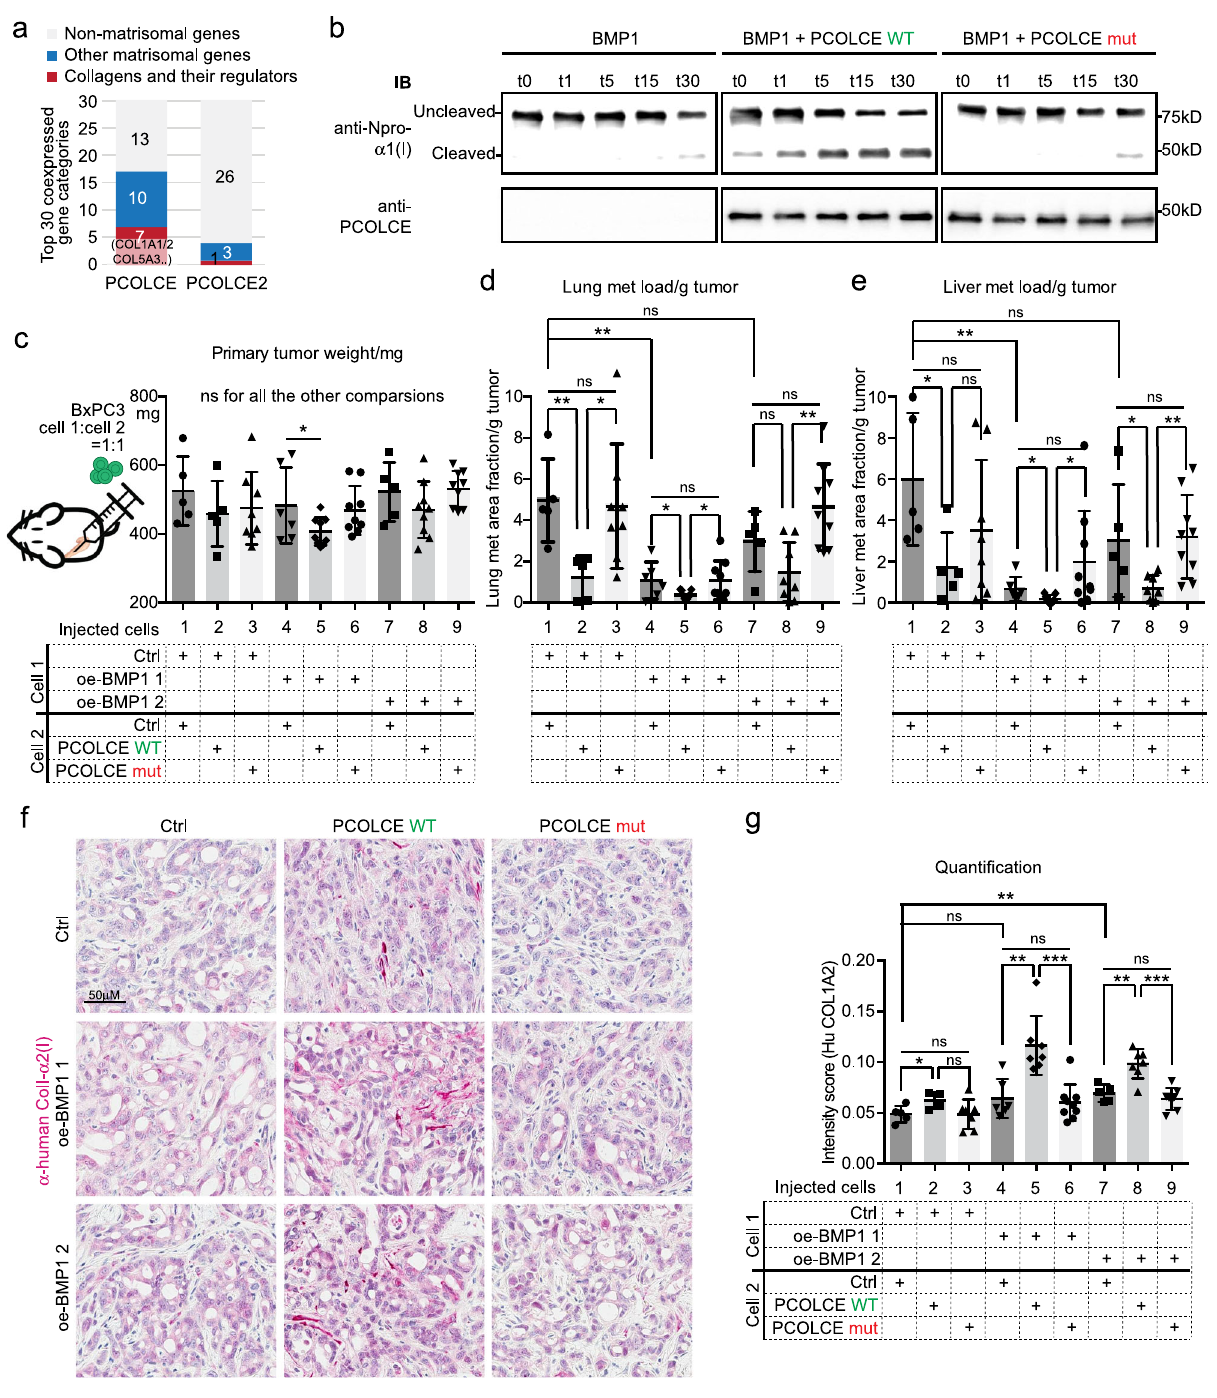
Fig. 6 PCOLCE promotes BMP1 suppression of metastasis. a The top 30 positively coexpressed genes ranked by correlation coef fi cients with PCOLCE have a higher fraction of matrisomal (blue or red) genes, especially collagen-related genes (red), than PCOLCE2 using the TCGA dataset in cBioPortal. b In vitro BMP1 cleavage assay suggested that WT PCOLCE, but not mut PCOLCE, could promote BMP1 cleavage of mini-pro α 1(I). See Fig. S7A – D for details of the cleavage assay. Images are representative of two independent experiments. c – e Orthotopic injection experiment using 1:1 mixes of cells that overexpress BMP1 and PCOLCE (WT or mut). c WT PCOLCE, but not mut PCOLCE, reduced primary tumor size of one of the lines overexpressing BMP (oe-BMP1 1; signi fi cant difference between lanes 4 and 5), but not the second (no difference between lanes 7 and 8 in c ). d , e Both BMP-oe lines expressing WT PCOLCE showed signi fi cant suppression of lung and liver metastasis (signi fi cant differences between lanes 4 and 5, and between lanes 7 and 8; images shown in Fig S7E). However, the mutant form of PCOLCE did not show the same effect (no signi fi cant difference between lanes 4 and 6, nor between lanes 7 and 9 in d and e ). Mouse numbers for each combination are 5, 5, 8, 6, 9, 9, 5, 9, 9 (left to right). f , g IHC on xenograft tumor sections ( f ) and the quanti fi cation ( g ) showed that cancer-cell-derived ColI was increased by oe-BMP1 and was further increased by the expression of WT PCOLCE but not that of mut PCOLCE (signi fi cant differences between lanes 4 and 5, and between lanes 7 and 8, but no difference between lanes 4 and 6, nor between lanes 7 and 9 in g ). N numbers are 5, 4, 7, 6, 7, 9, 5, 7, 8 (left to right). All p -values come from two-tailed Student ’ s t tests. All columns are represented by mean ± SD.